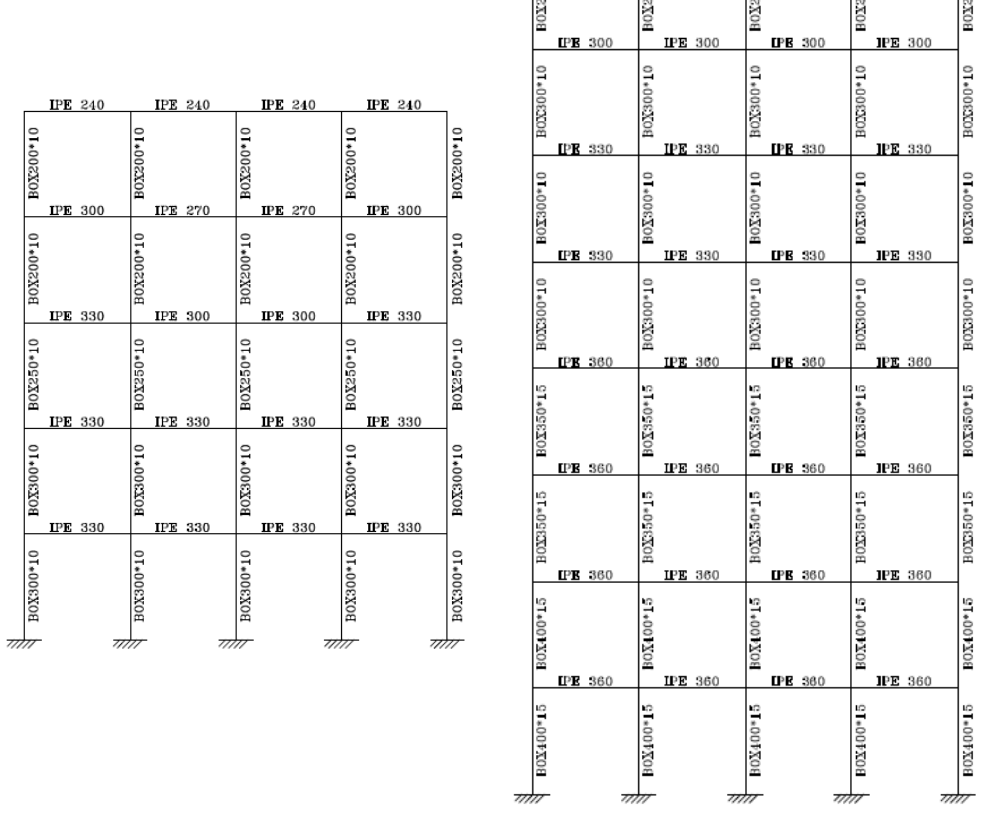
Figure 2. Cross sections of structural members of five-story and eight-story buildings.